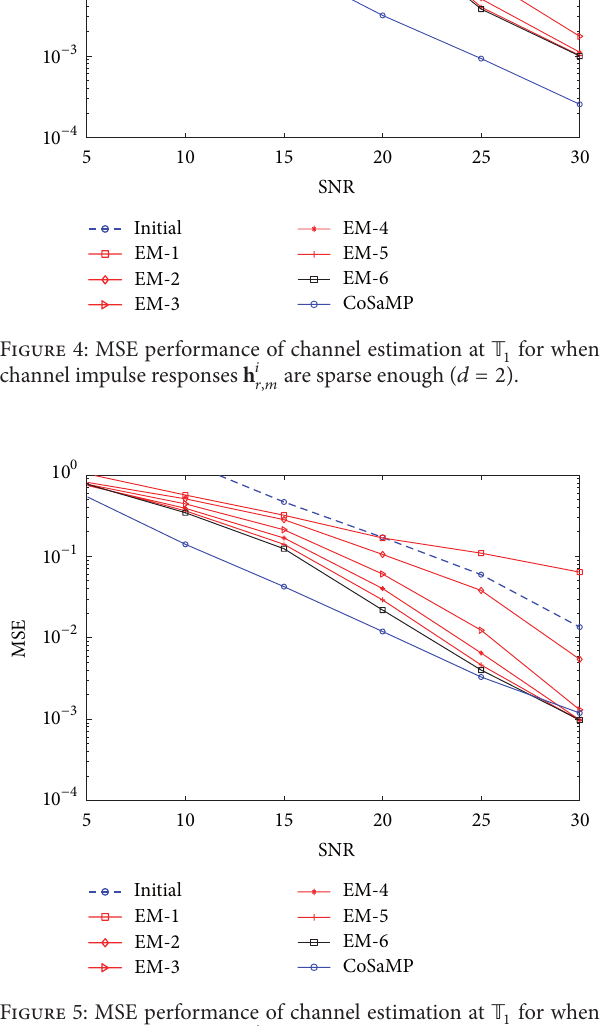
Figure 5: MSE performance of channel estimation at T 1 for when channel impulse responses h 𝑖 𝑟,𝑚 are sparse ( 𝑑 = 4